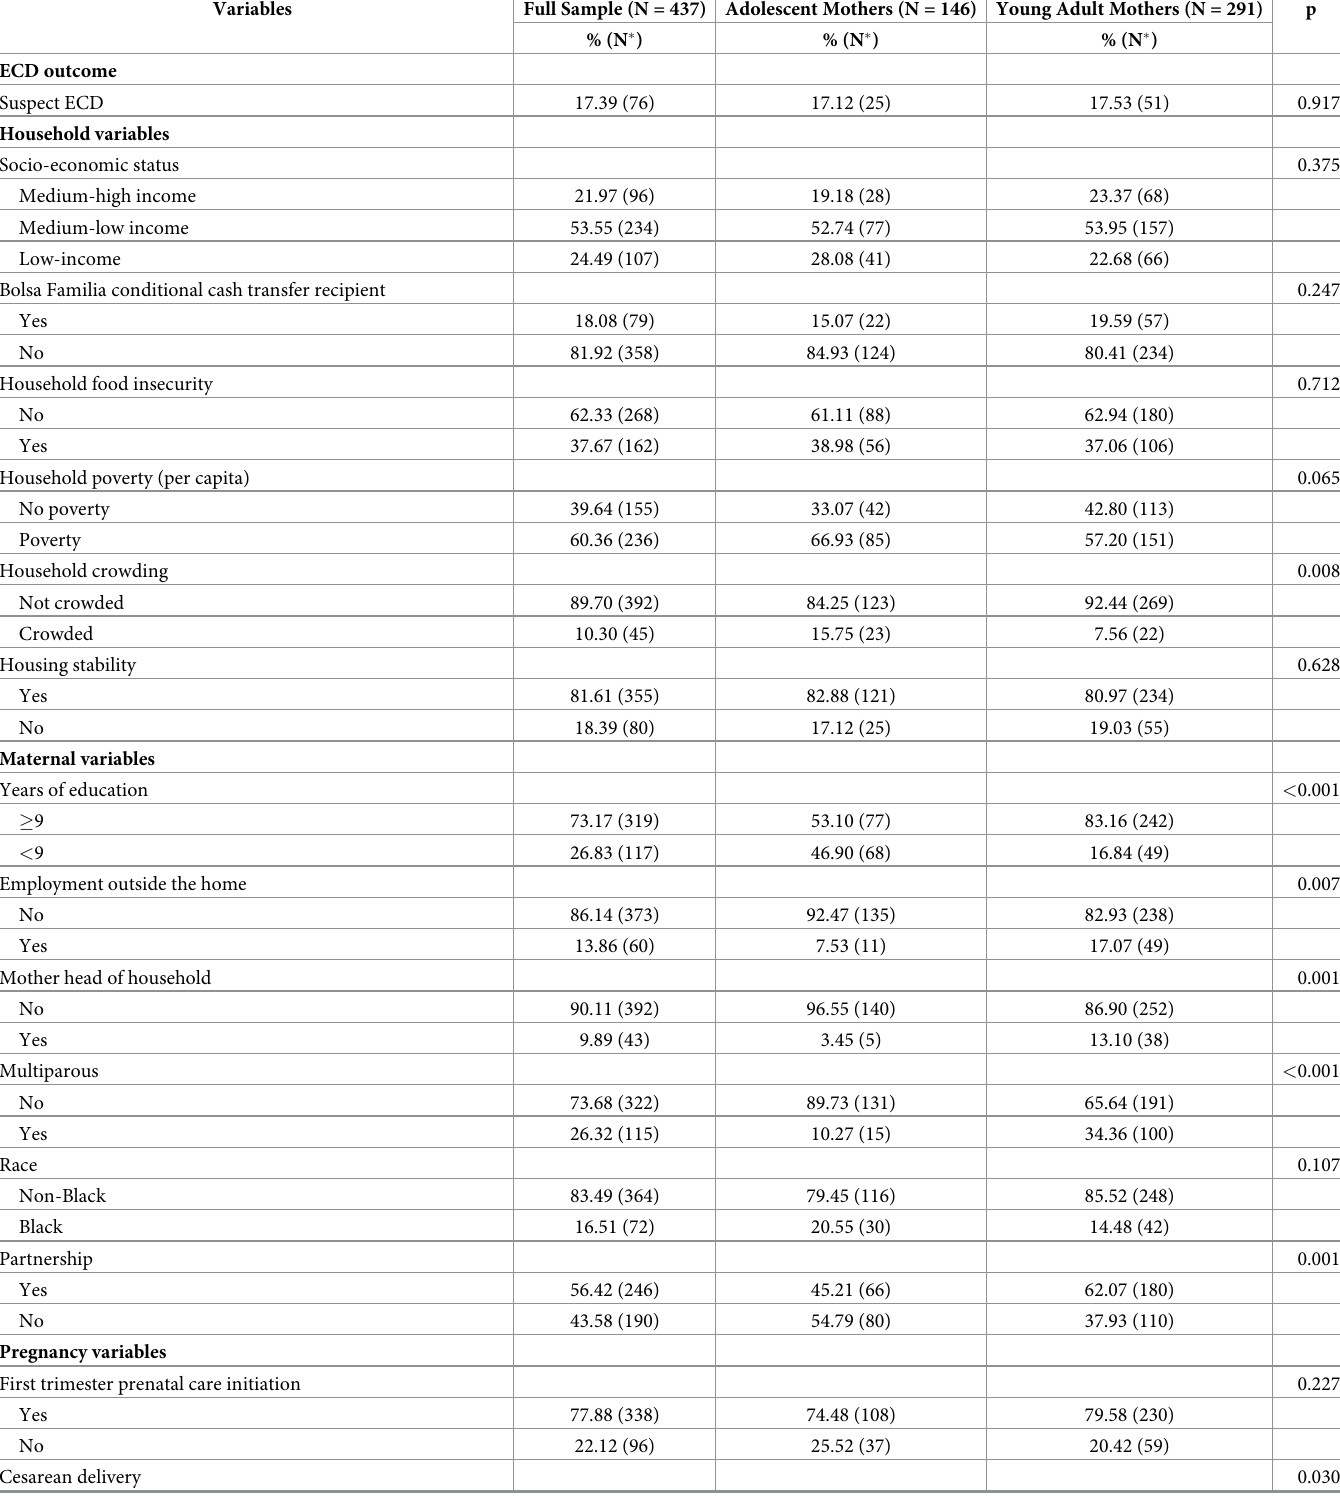
Table 1. Characteristics of adolescent and young adult mothers with children under 2 years old by maternal age, Brası´lia, Brazil,